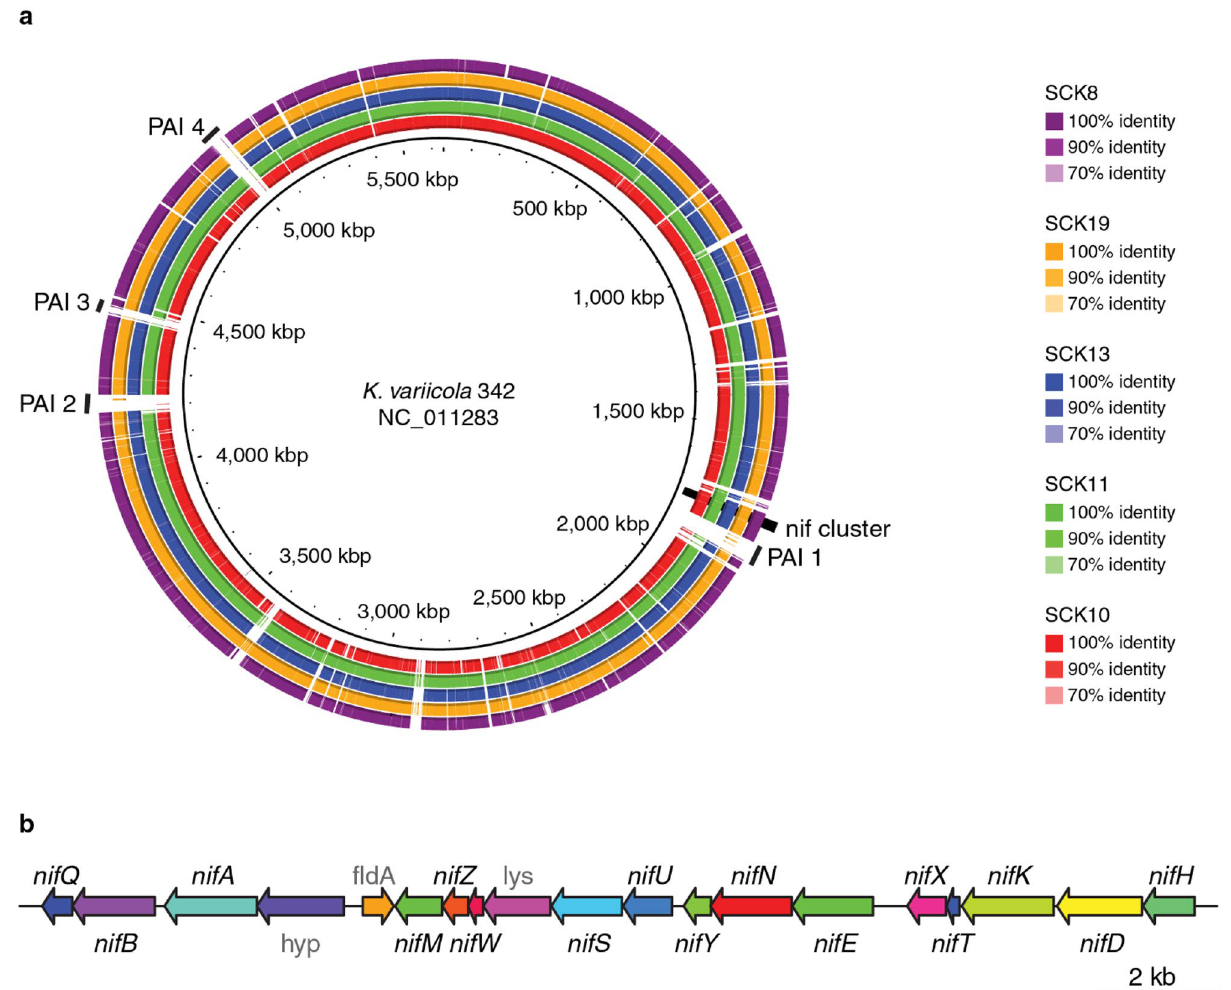
Figure 2. Comparison of the K. variicola type strain 342 to K. variicola sugarcane isolates characterized here. ( a ) BLAST ring plot showing synteny and sequence similarity between K. variicola 342 and five K. variicola sugarcane isolates. The K. variicola 342 genome sequence is shown as the inner ring, and syntenic regions of the five K. variicola sugarcane isolates are shown as rings with strain-specific color-coding according to the percent identity between regions of K. variicola 342 and the sugarcane isolates. The genomic locations of nif operon cluster along with four important pathogenicity islands (PAIs) are indicated. PAI1—type IV secretion and aminoglycoside resistance, PAI2 hemolysin and fimbria secretion, heme scavenging, PAI3—radical S-adenosyl- L-methionine (SAM) and antibiotic resistance pathways, PAI4—fosfomycin resistance and hemolysin production. ( b ) A scheme of the nif operon cluster present in both K. variicola 342 and the five K. variicola sugarcane contribute positive values, whereas the presence of virulence factors and predicted antibiotic resistance yield negative values. Scores for each of the four specific phenotypic categories were normalized and combined to yield a single composite score for each bacterial isolate genome. The highest scoring isolates are predicted as best candidates to be included as part of a sugarcane biofertilizer inoculum. The predicted biochemical capacities of the highest scoring isolates were subsequently experimentally validated. The results of the computational phenotyping analysis for the 22 bacterial isolate genome sequences charac- terized here are visualized as a heatmap in Fig. 4, and the presence/absence patterns for all of the genes analyzed here are shown in Supplementary Table S2. Isolates are ranked according to their composite genome scores, with the highest potential (10.87) for biofertilizers production shown at the top. Individual gene and phenotype scores are color coded for each genome, and the four functional-specific categories are shown separately. Individual gene results are shown for the nitrogenase ( nif ) genes, whereas genes are combined into functional sub-categories for the plant growth promoting and virulence factor genes. Predicted antimicrobial resistance phenotypes are shown for individual antibiotic classes. The nif gene presence/absence profiles are highly similar for all but four of the bacterial isolates characterized here. These four isolates do not correspond to the Klebsiella genus, or closely related species, and do not encode any nif genes. These four isolates represent bacterial species that are commonly found in soil 21–25 , but they are